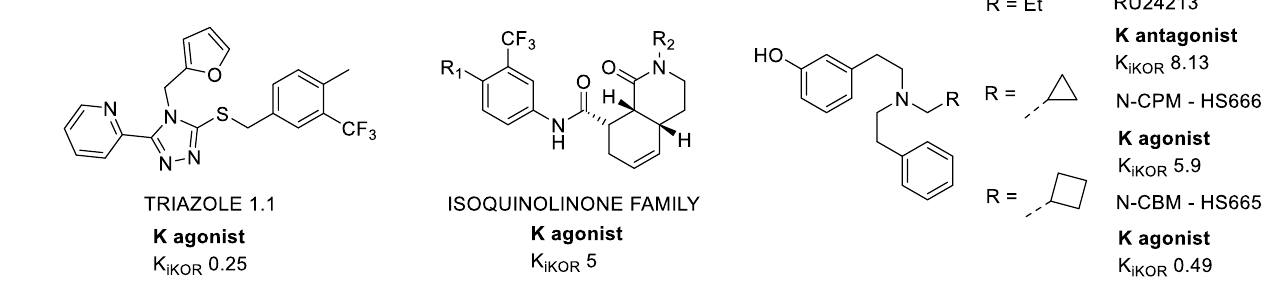
Figure 3. Examples of KOR agonists: triazoles, isoquinolines, and diphenethylamines. K i values are also shown (nM).